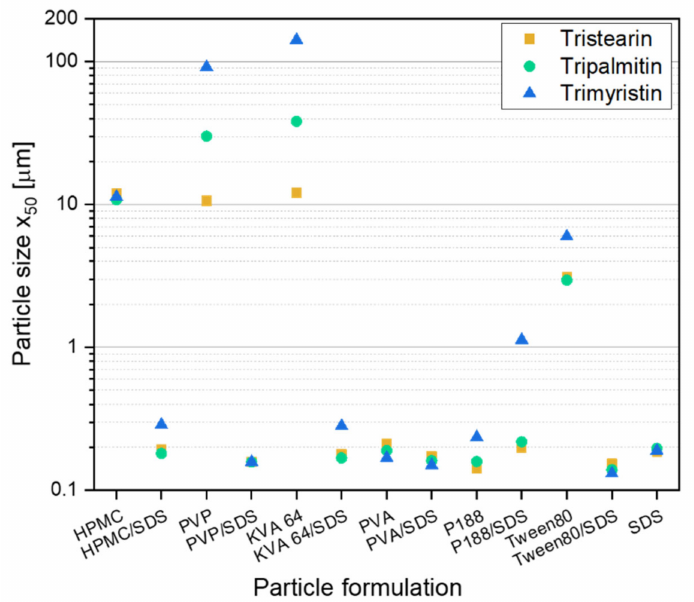
Figure 1. Results of the screening experiments in a dual centrifuge (10 min at 60 ◦ C and 2350 rpm) with different stabilizer formulations for the stabilization of particles from the solid lipids tristearin, tripalmitin and trimyristin (10% lipid in